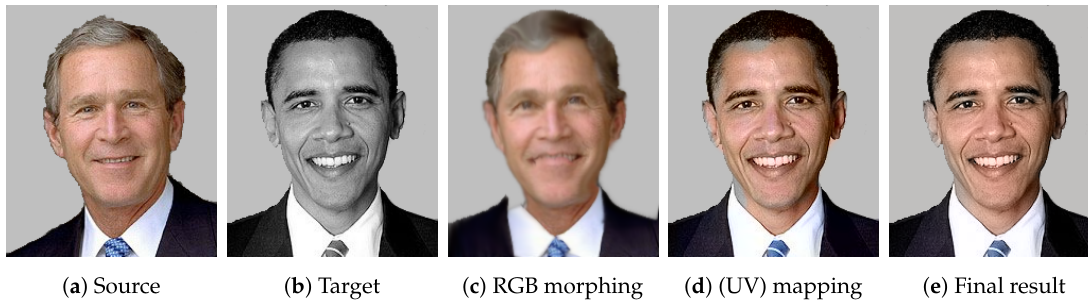
Figure 4. Illustration of the colorization steps of our algorithm. ( a ) The color source image; ( b ) The gray value target image; ( c ) The transport of the R , G , B channel via the morphing map is not suited for colorization; ( d ) The result with our morphing method is already very good; ( e ) It can be further improved by our variational post-processing.